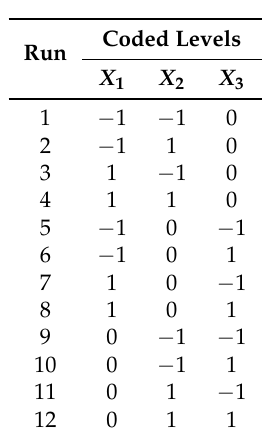
Table 1. Experimental matrix of Box–Behnken